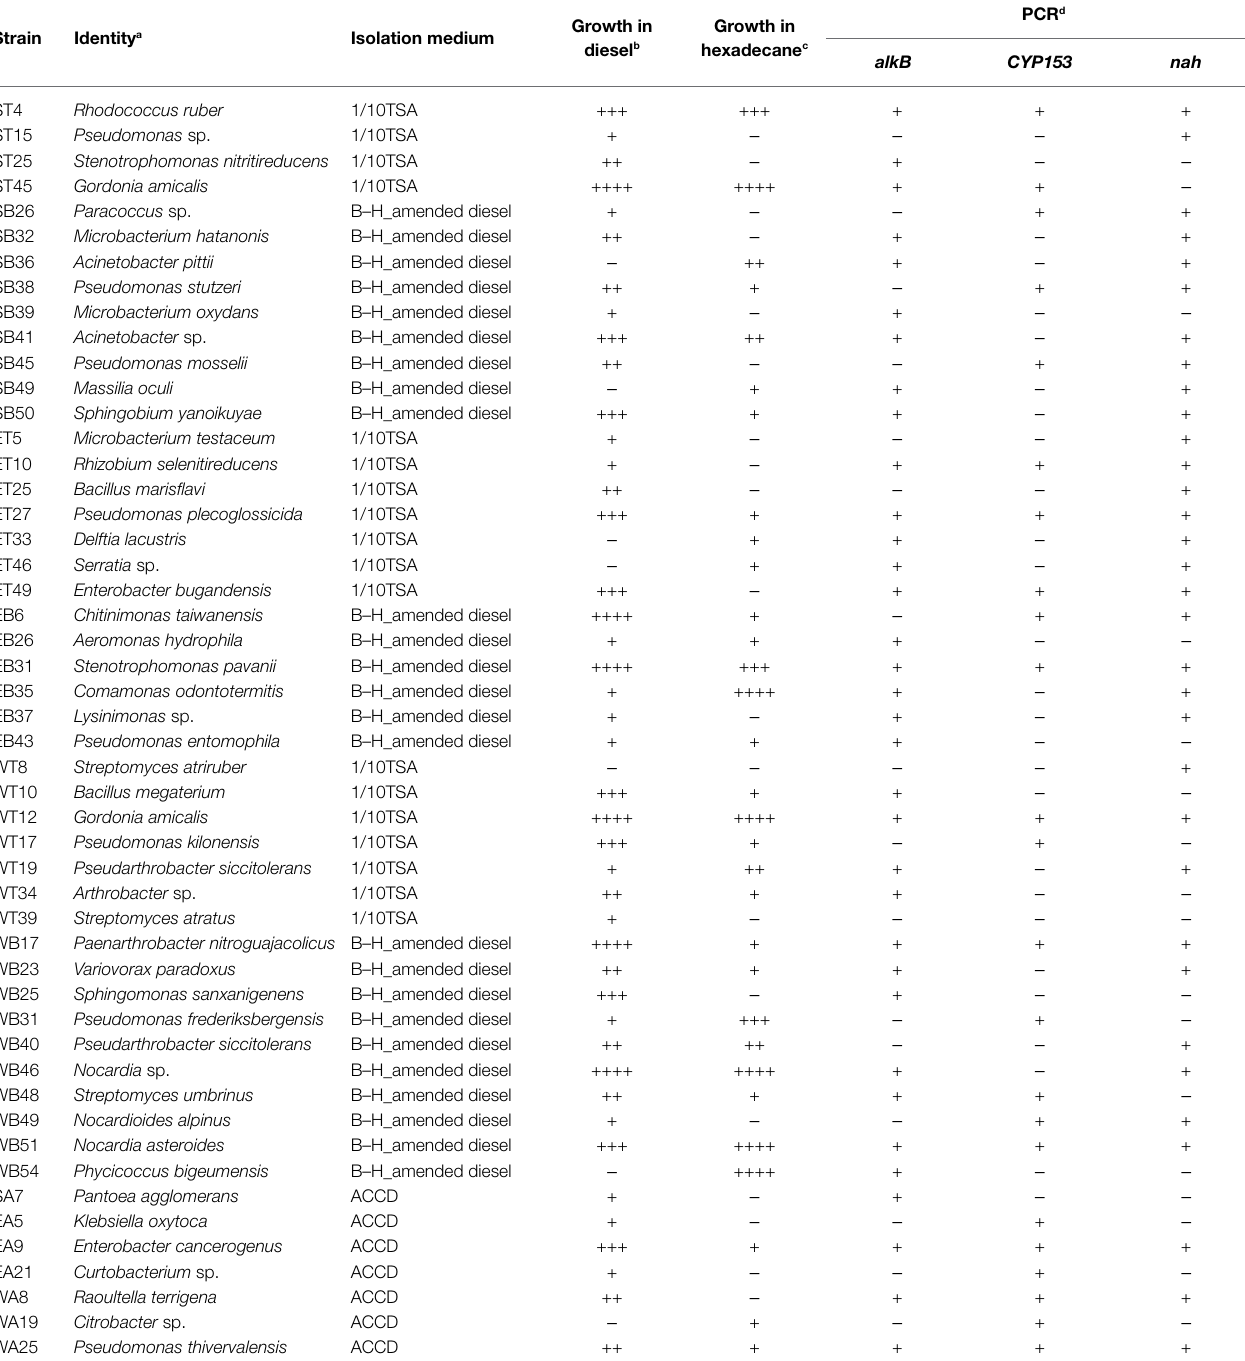
a Indicates 16S rDNA identity of bacterial strains with their closest type strains in GenBank. b Indicates growth capability of bacterial strains on 1% (v:v) diesel in MSM. ++++, +++, ++, +, and − , indicating the growth capability from strong to weak with diesel as a sole carbon and energy source, measured by optical density at 600 nm, after 1 week incubation at 28 ° C. ++++, growth (OD600 > 1); +++, growth (OD600 > 0.6); ++, growth (0.6 > OD600 > 0.2); +, growth (OD600 < 0.2); and − , no growth. c Indicates growth capability of bacterial strains on 1% (v:v) n-hexadecane in MSM. ++++, +++, ++, +, and − , indicating the growth capability from strong to weak with n-hexadecane as a sole carbon and energy source, measured by optical density at 600 nm, after 1 week incubation at 28 ° C. ++++, growth (OD600 > 1); +++, growth (OD600 > 0.6); ++, growth (0.6 > OD600 > 0.2); +, growth (OD600 < 0.2); and − , no growth. d Indicates “ − ” absence of PCR products and “ + ” presence of PCR products for the functional genes: alkB, alkane monooxygenase; CYP153, cytochrome P450 hydroxylase;